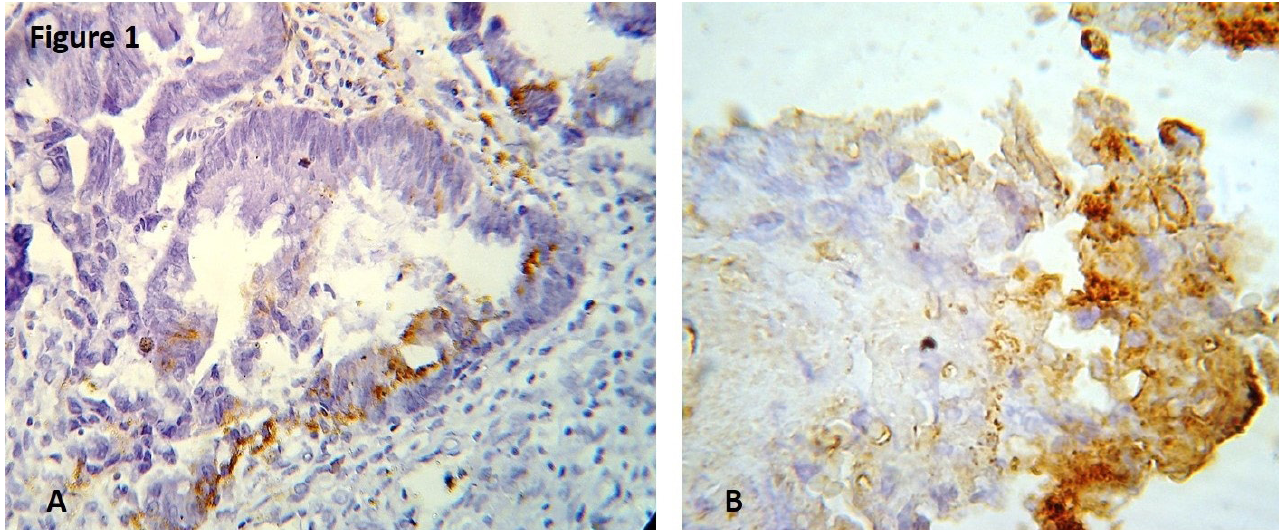
Fig.1. Immunohistochemical expression of TIMP-2 in A: colon cancer (positive control), B: OSCC Brown cytoplasmic granular staining in poor differentiated oral squamous cell cancer, strong immunostaining (score 3), (X